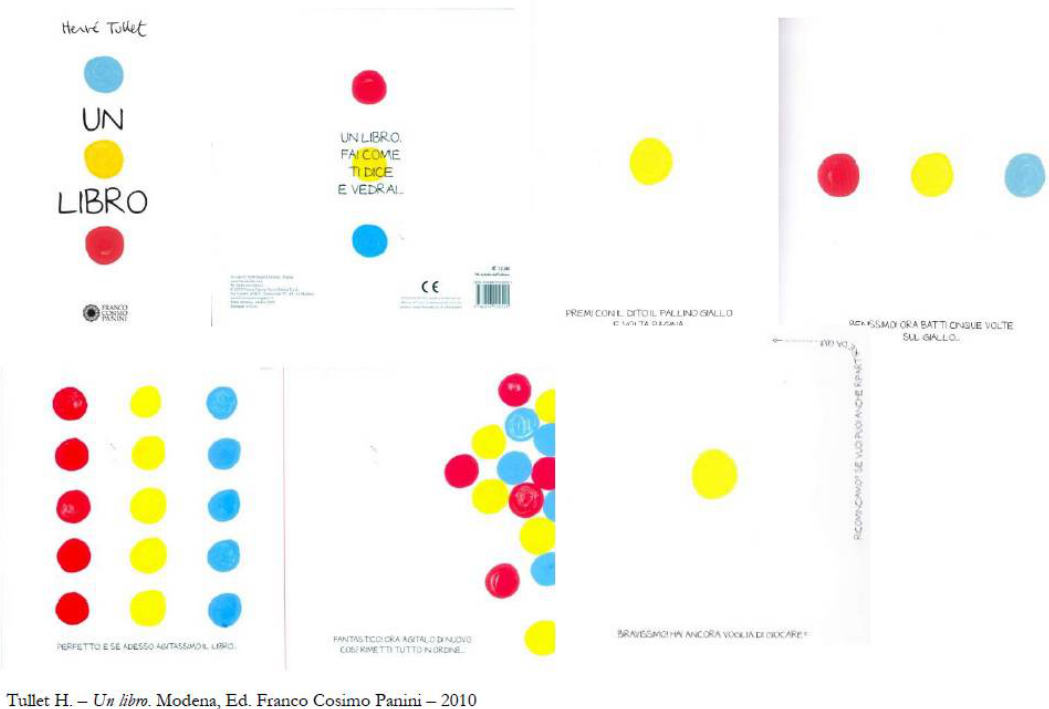
Figure A5. Tullet H.— Un libvo. Modena, Ed. Franco Cosimo Panini—2010.